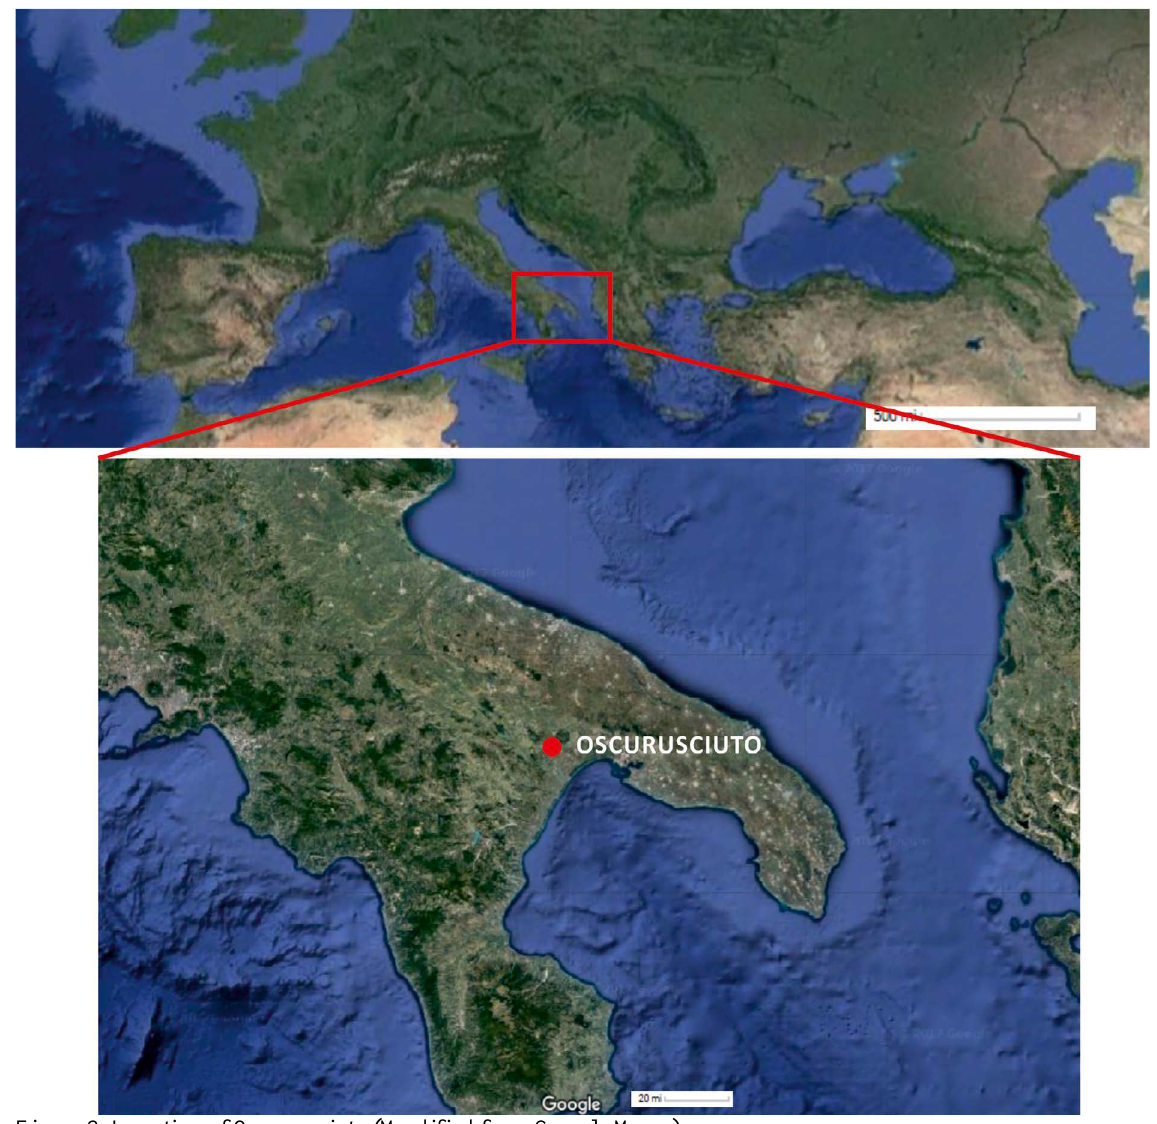
Figure 2. Location of Oscurusciuto (Modified from Google